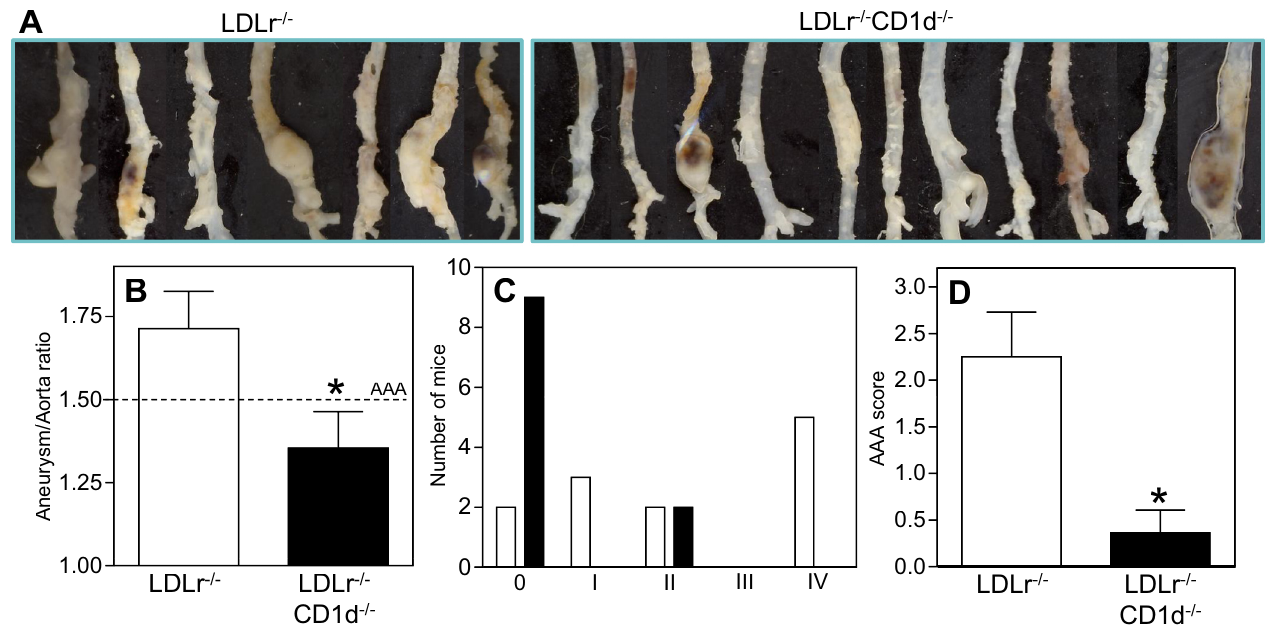
Fig 2. Reduced aneurysm formation in LDLr -/- CD1d -/- mice. Osmotic pumps filled with Ang II were implanted in LDLr -/- (n = 12) and LDLr -/- CD1d -/- (n = 11) mice which were fed a Western type of diet for 1 week. Aneurysm formation in the surviving LDLr -/- mice (n = 7) and LDLr -/- CD1d -/- mice (n = 11) was determined by dissecting the aorta (A) and measuring the ratio between the maximal diameter of the abdominal AAA-affected part and the maximal diameter of the “healthy” thoracic part of the aorta (B). Scoring of the severity of the aneurysms was performed using the visual determination method as described by Daugherty et al., 2011 (C, D). All values are mean ± SEMand statistical analysis was performed using the unpaired two-tailed student’s T-test. (cid:3) P < 0.05.